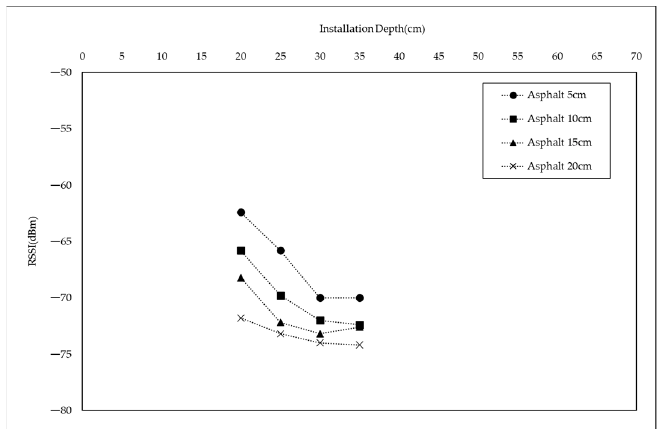
Figure 6. A test result of surface layer